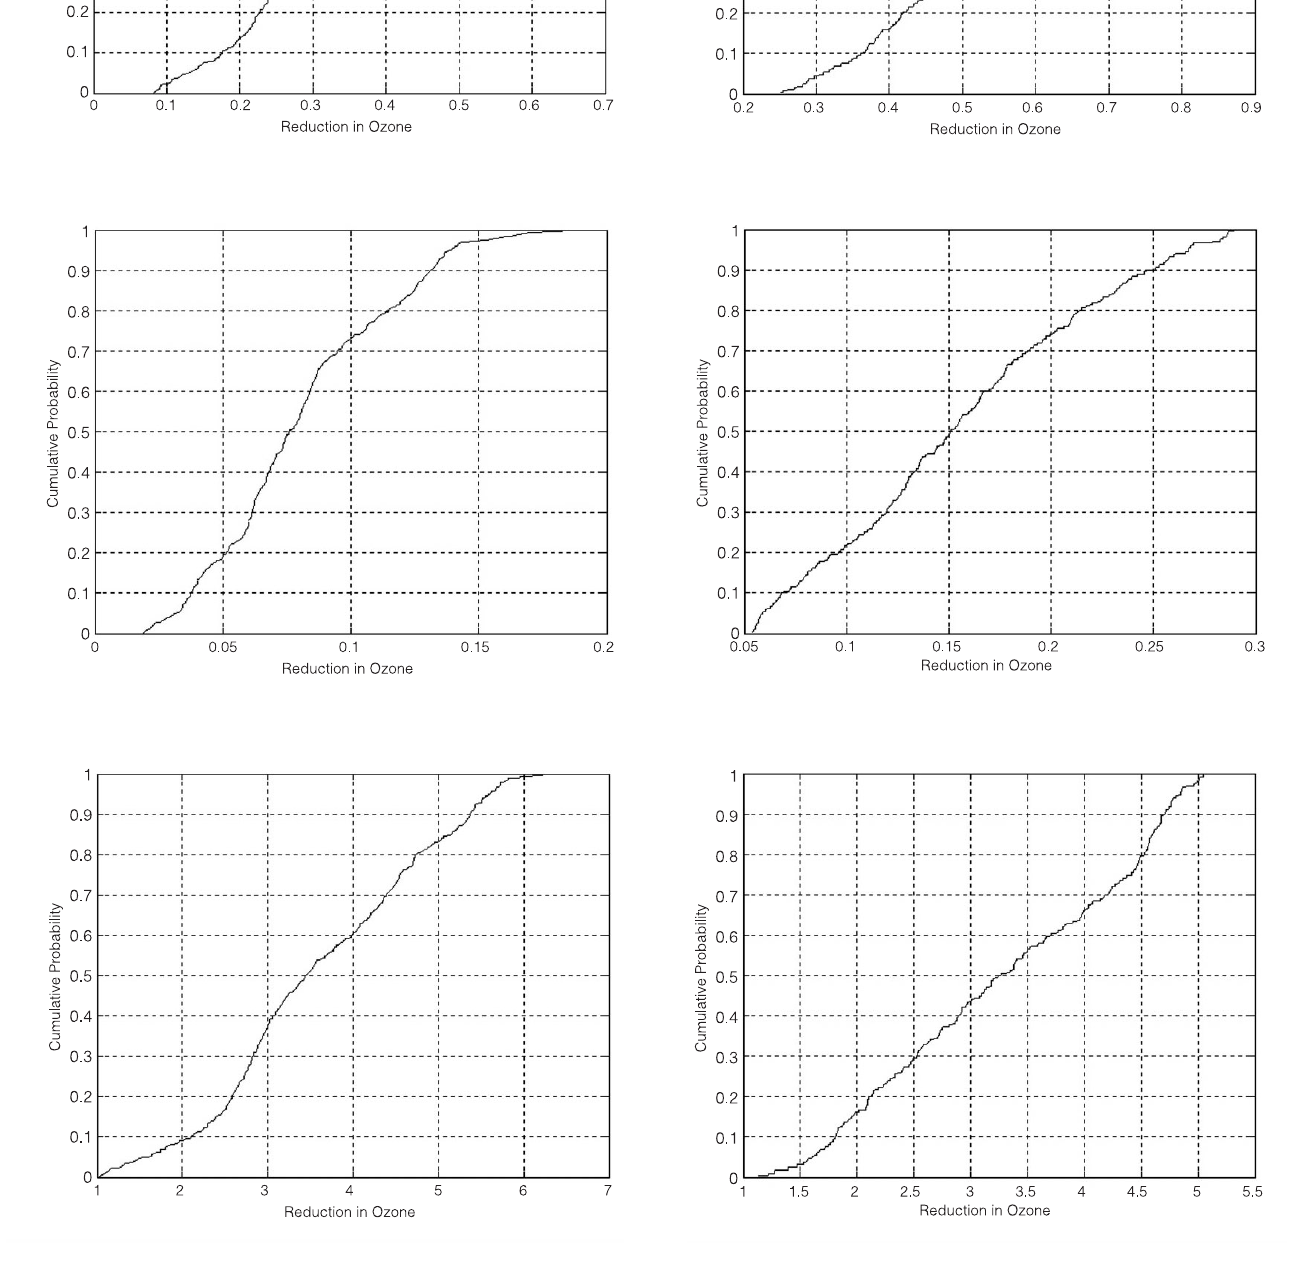
, NO , VOC) at the time of the observed O 3MAX , for perturbations at 3 X ( top ), VOC ( middle ) and NO ( bottom ), for Athens ( left ) and Milan ( right 3 X